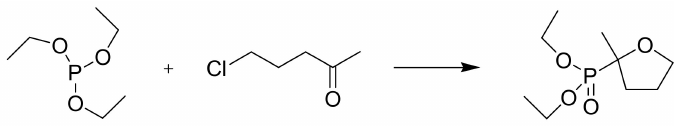
Scheme 19. Reaction of γ -haloketones with